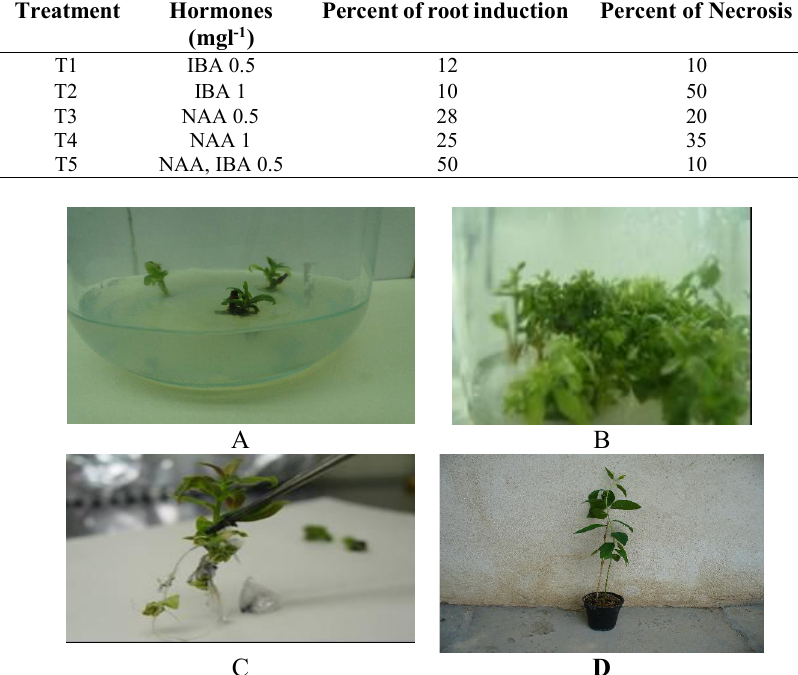
Fig. 1. The different stages of Eucalyptus globules micro propagation. A: Culture of buds, B: Proliferation of shoots, C: Rooting of shoots, D: In vitro